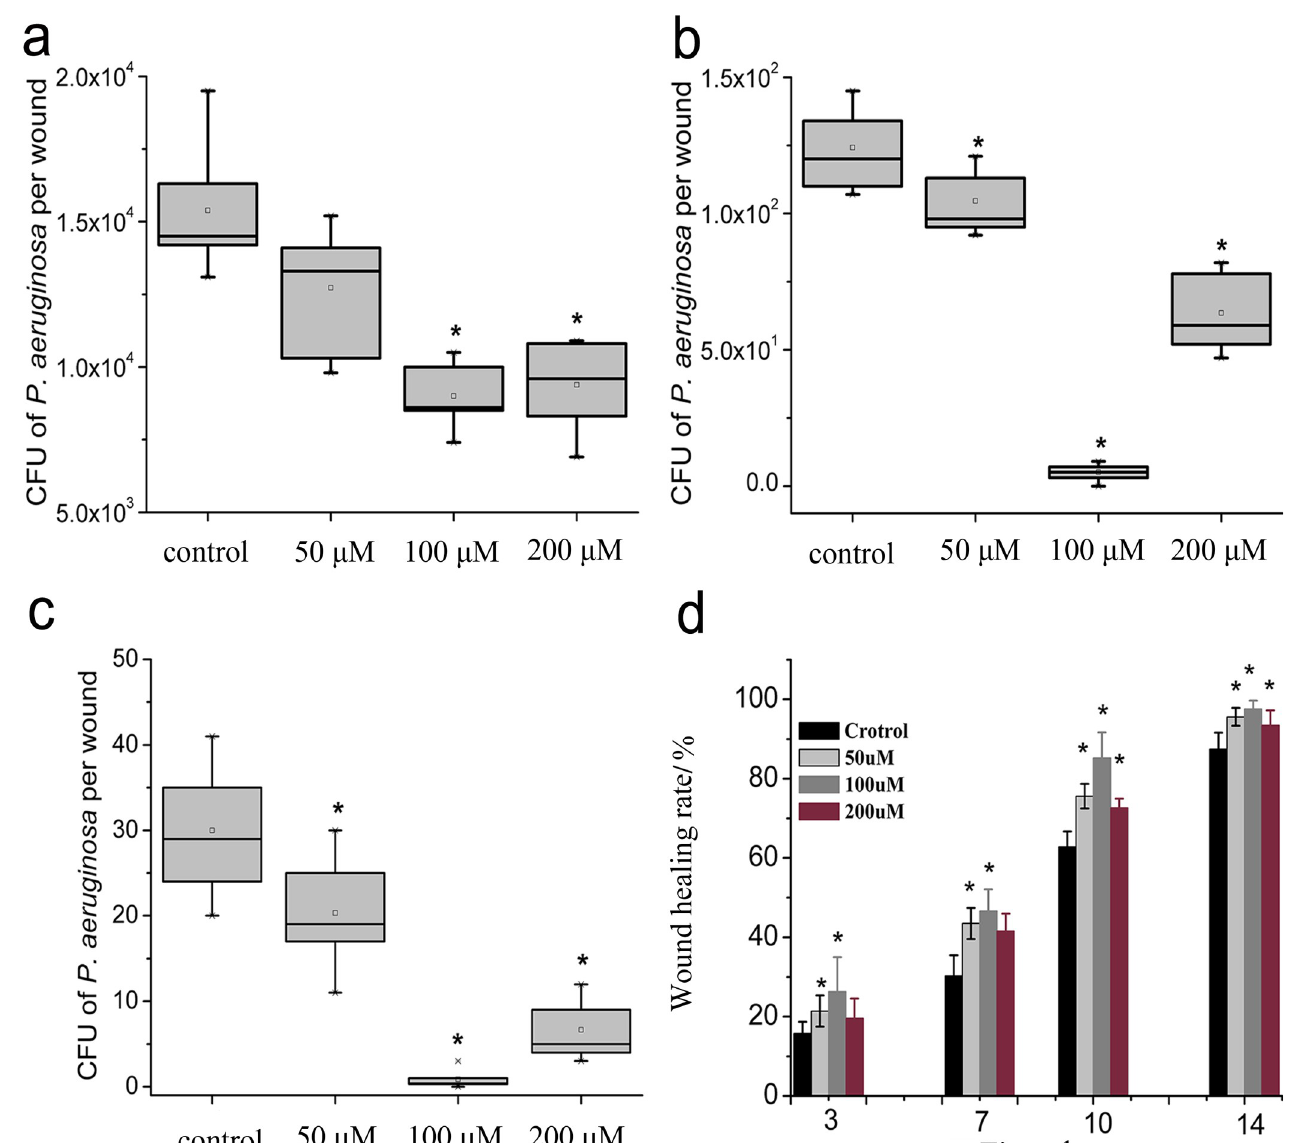
Fig 9. Box plot of the viability of bacteria in wounded tissue in mice on days (a) 1, (b) 10, and (c) 14 ( � P < 0.05, significant difference versus the control group). (d) Wound healing rate in the protoporphyrin IX–ethylenediamine derivative-mediated photodynamic antimicrobial chemotherapy (PPIX-ED-PACT) and control groups on days 3, 7, 10, and 14 after treatment ( � P < 0.05, significant difference versus the control